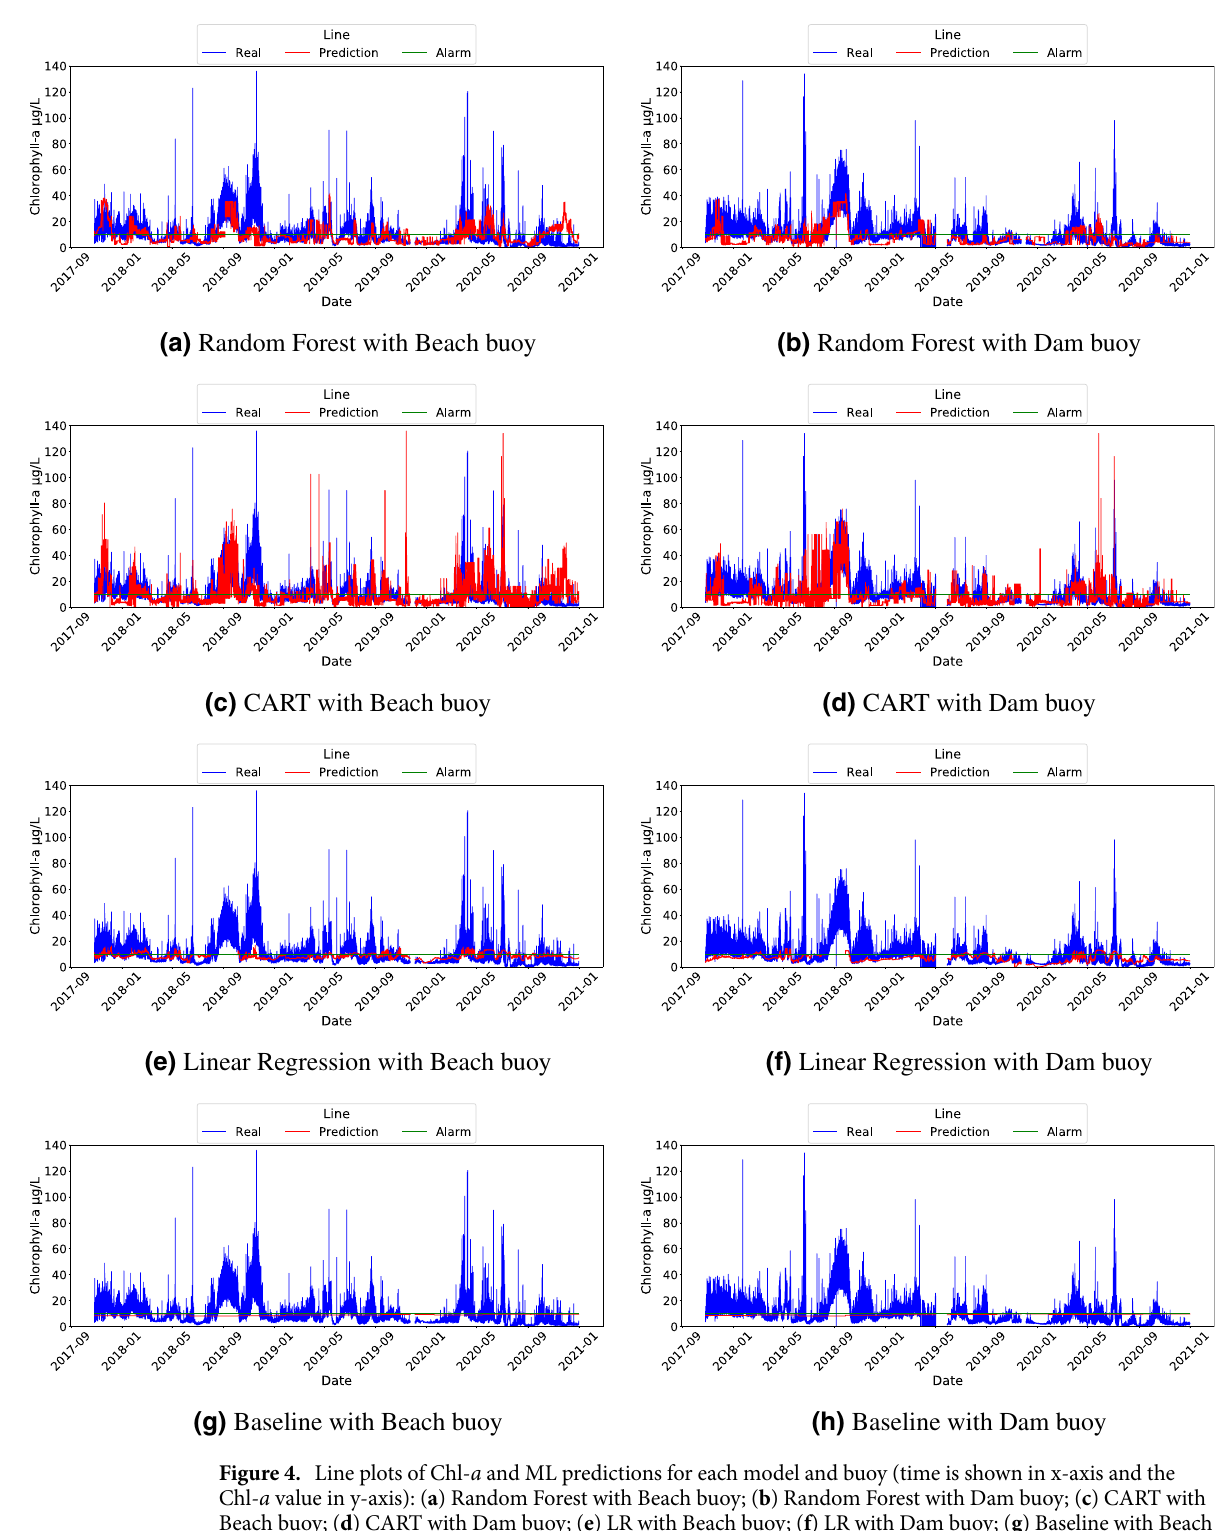
Figure 4. Line plots of Chl- a and ML predictions for each model and buoy (time is shown in x-axis and the Chl- a value in y-axis): ( a ) Random Forest with Beach buoy; ( b ) Random Forest with Dam buoy; ( c ) CART